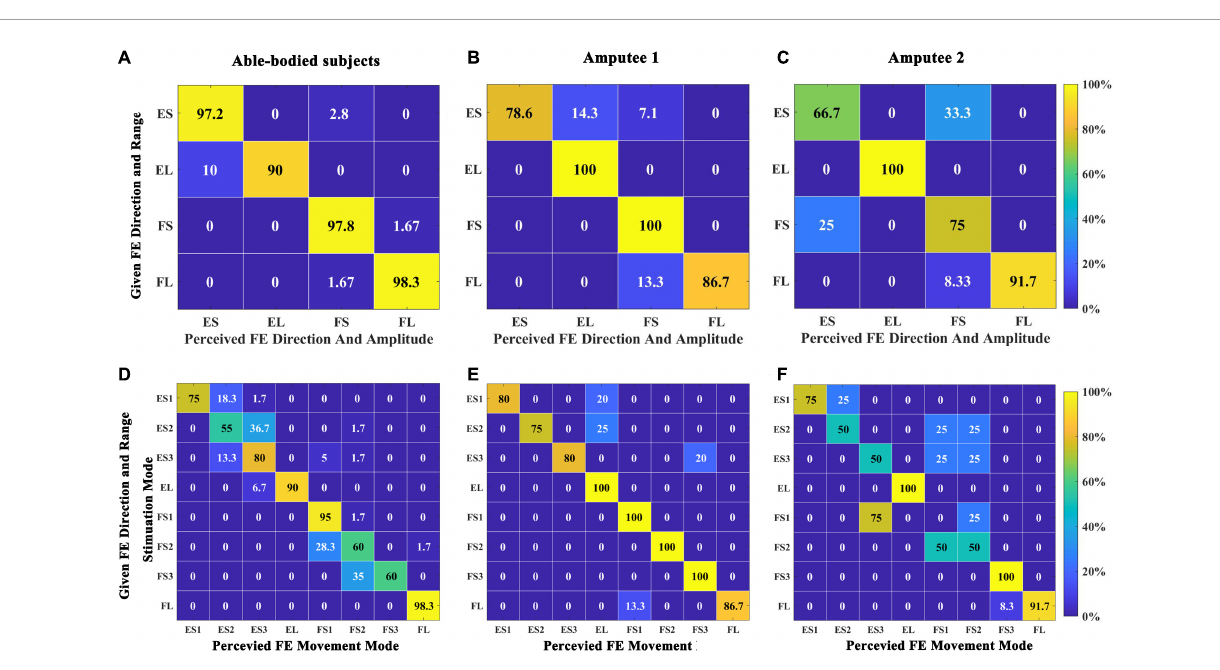
FIGURE8 Confusion matrix quantifying the percentage of instances when comparing the perceived direction and range of wrist FE movements with the given stimulation in Exp 2. (A) Five able-bodied subjects. (B) Amputee 1. (C) Amputee 2. Confusion matrix quantifying the percentage of instances when comparing the perceived wrist movement stimulation mode with a given stimulation mode in Exp 2. (D) Five able-bodied subjects. (E) Amputee 1. (F) Amputee 2. The number in each rectangle represents the SR of the